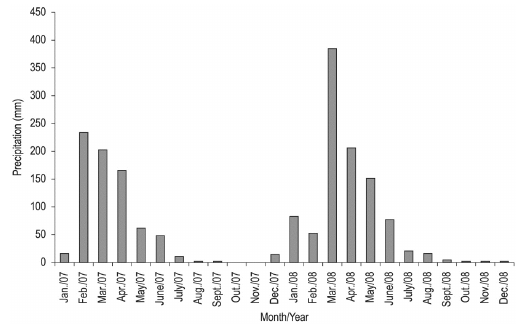
Figure 2. Pluviometric precipitations of the years of 2007 and 2008, in the Apodi/Mossoró river hydrographic